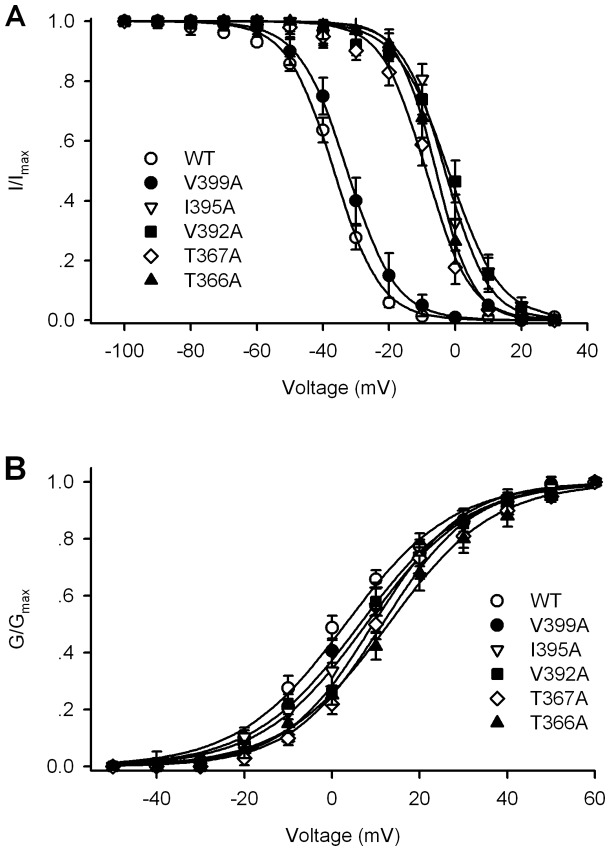
Alteration of availability and activation conductance of mutant hKv4.3 channels.
A. Mean values of the variables of availability (I/Imax) of WT and mutant hKv4.3 channels. B. Mean values of the variables of activation conductance (G/Gmax) of WT and mutant hKv4.3 channels.